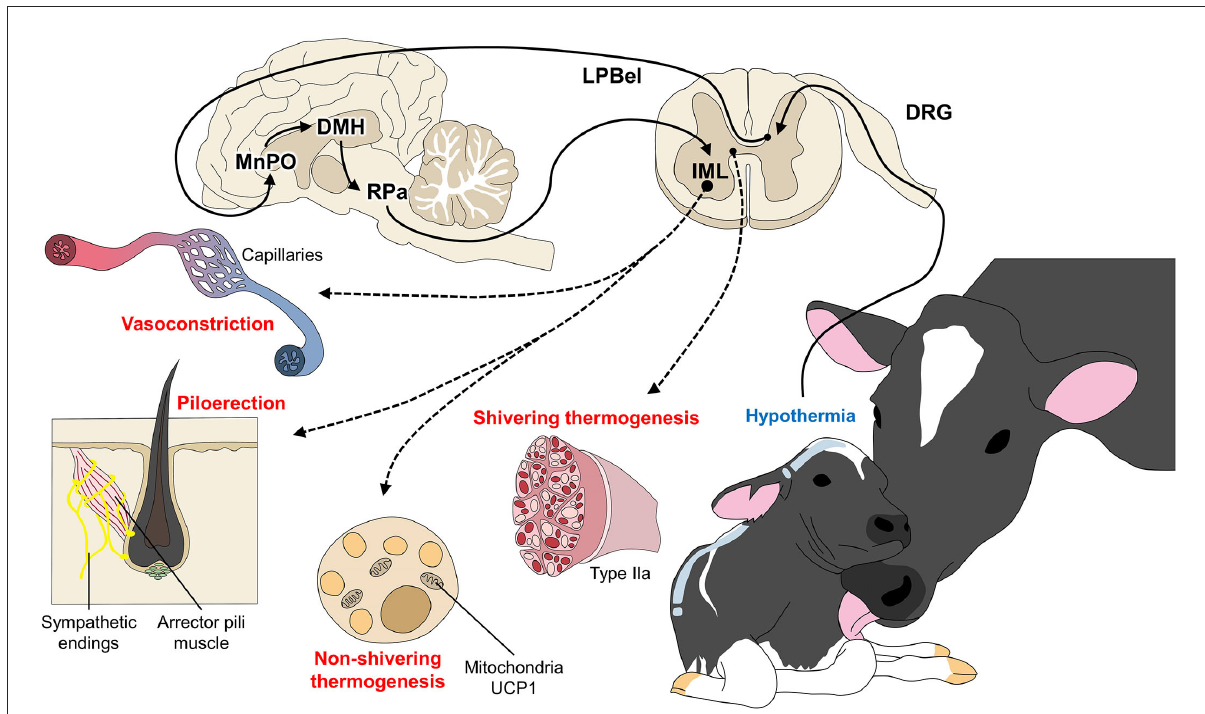
FIGURE4 Peripheral responses as coping mechanisms for hypothermia. When the thermoregulatory center of the central nervous system (MnPO) perceives a decrease in body temperature, the organism of newborn ruminants (and other mammals) activates peripheral responses with two main objectives: (A) to prevent heat loss through vasoconstriction and piloerection; and (B) to produce heat by shivering and non-shivering thermogenesis, where BAT and skeletal muscle fibers participate in the return to a state of